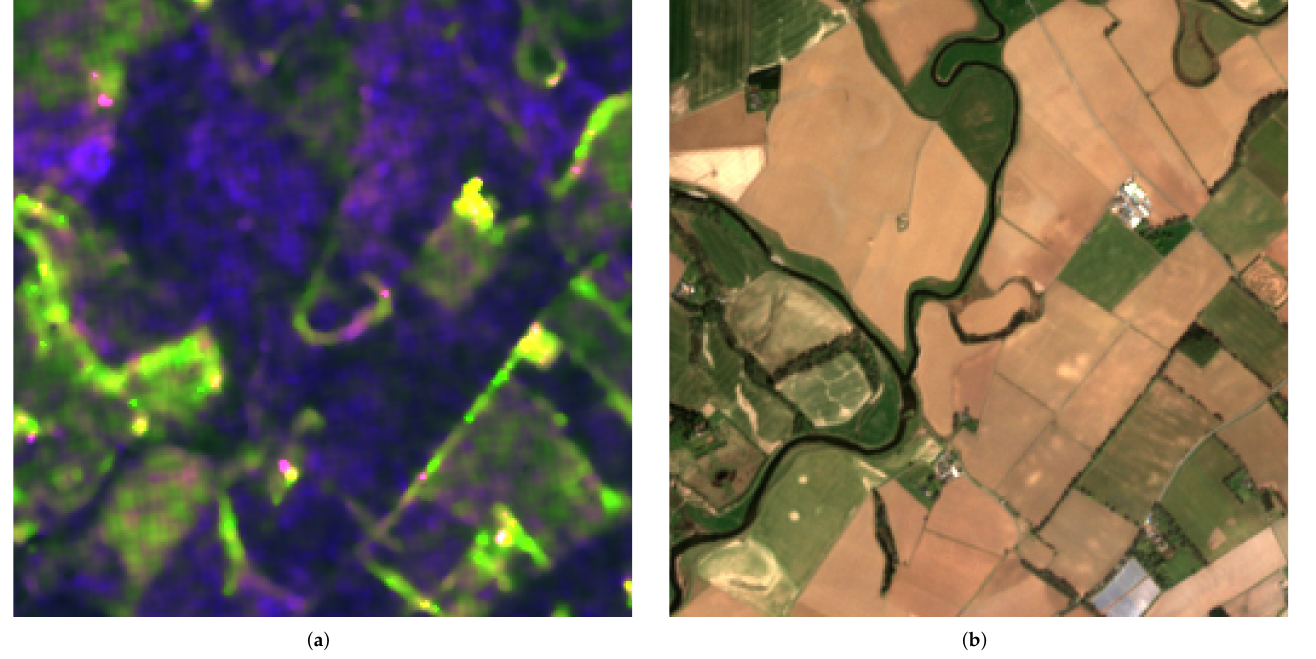
Figure 9. Collocated Sentinel-1 and Sentinel-2 patch: ( a ) False colour composite of a Sentinel-1 patch (red channel as VV, green channel as VH and blue channel as VV/VH), ( b ) RGB colour composite of a Sentinel-2